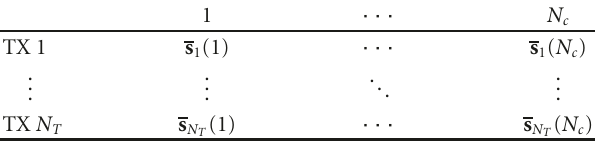
Table 1: Transmission structure of training sequences ( N T >